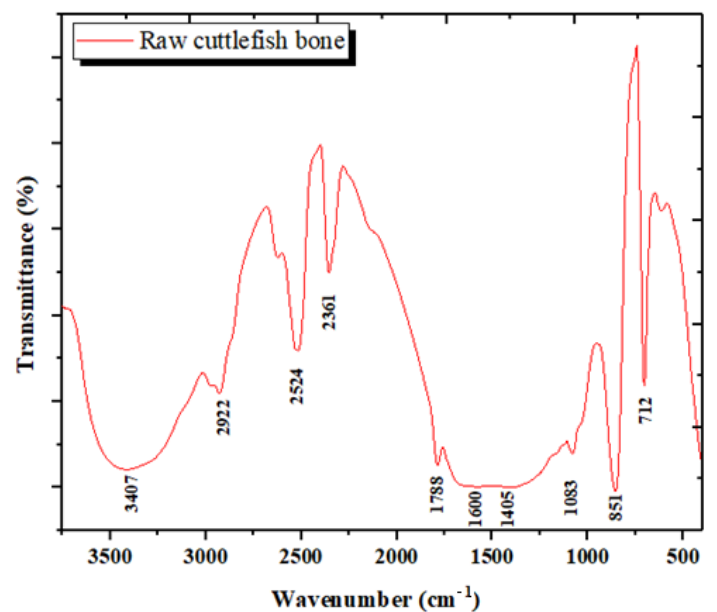
Figure 5. ATR FT-IR spectrum of raw CB powder.